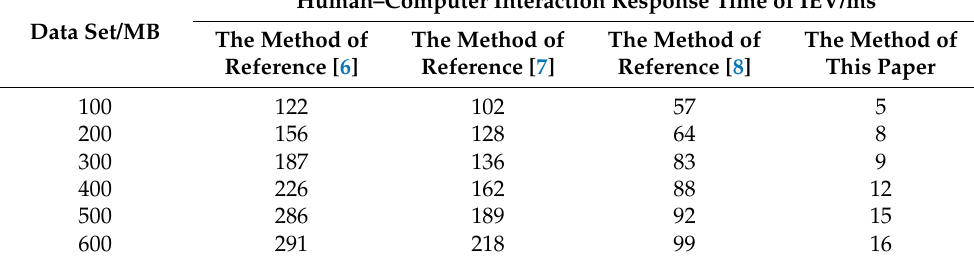
Table 2. Human–computer interaction response time of an IEV.